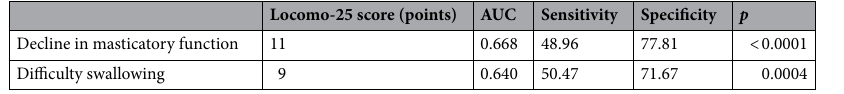
Table 3. Threshold score of Locomo-25 for “decline in masticatory function” and “difficulty swallowing”. Receiver operating characteristic curve analysis was performed. AUC area under the curve.